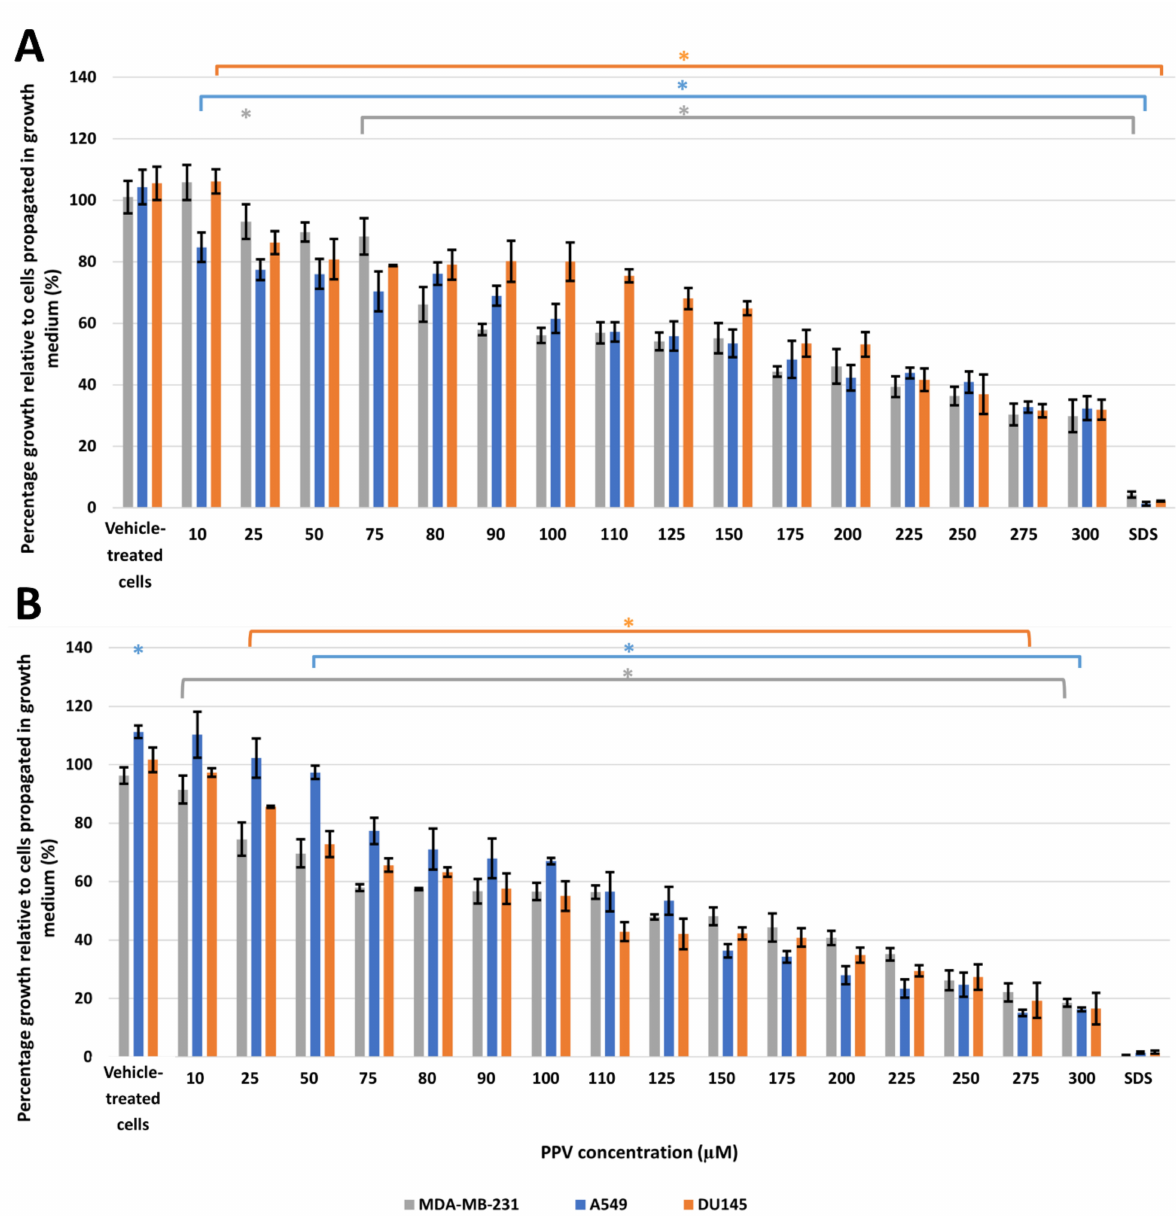
Figure 1. Spectrophotometry results of crystal violet staining demonstrating the effects of PPV (10–300 µ M) on proliferation on MDA-MB-231, A549, and DU145 cell lines at 48 h ( A ) and 72 h ( B ). The average of three independent experiments is represented by the graph with error bars indicating standard deviation. The statistical significance is represented by an * when using the Student t-test with a p value of 0.05 compared to cells propagated in growth